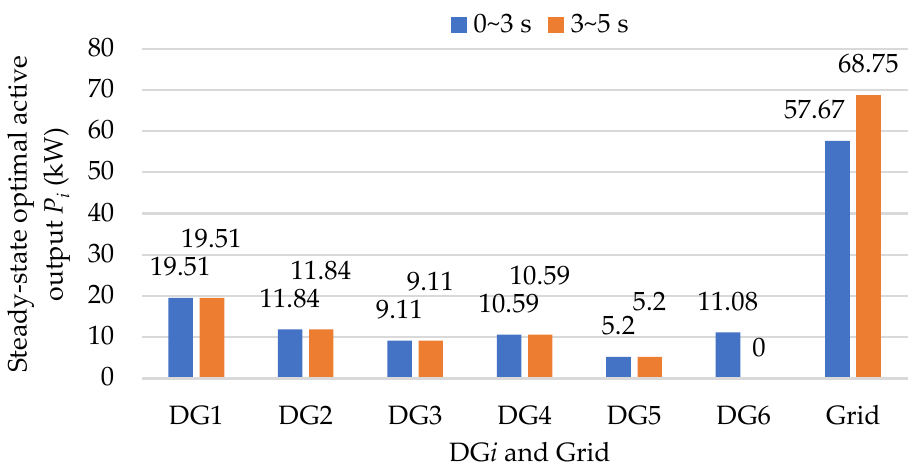
Figure 26. Comparison of steady-state optimal active output of each DG before and after the exiting of